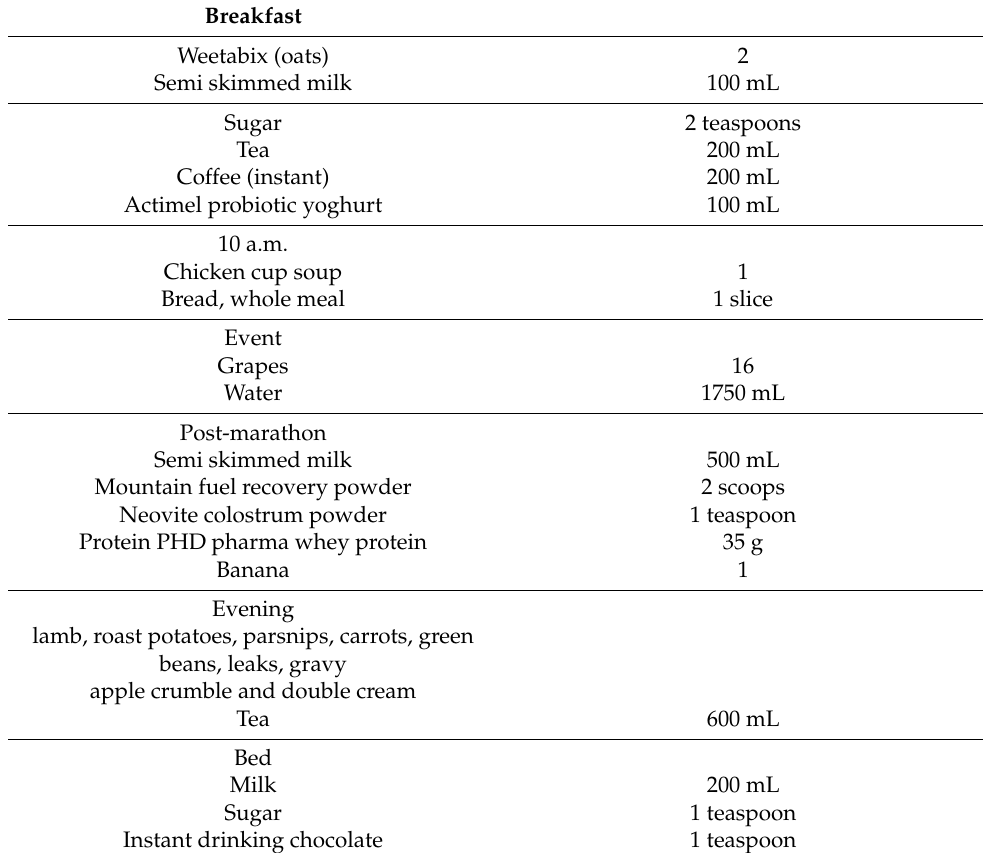
Table 4. Example food and drink for a typical